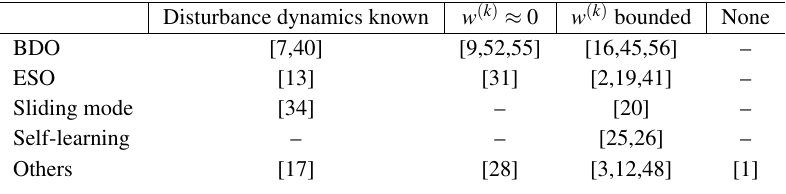
Table 1. Overview of papers with different approaches for estimation of disturbance